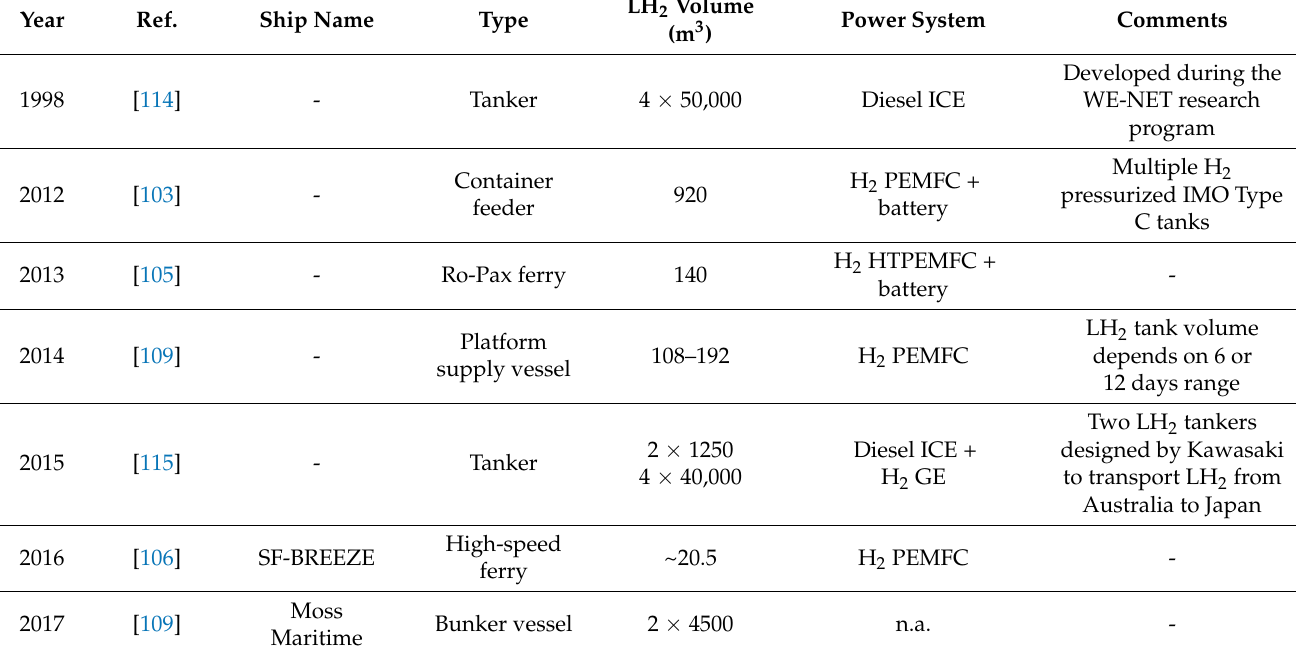
Table 4. Feasibility studies and design of LH 2 ships ordered chronologically (abbreviations: DFDE: dual-fuel diesel-electric, H 2 : hydrogen, ICE: internal combustion engine, PEMFC: polymeric elec- trolyte membrane fuel cell, GE: gas engine, CCGT: combined cycle gas turbine, Li-ion: lithium-ion, n.a.: not